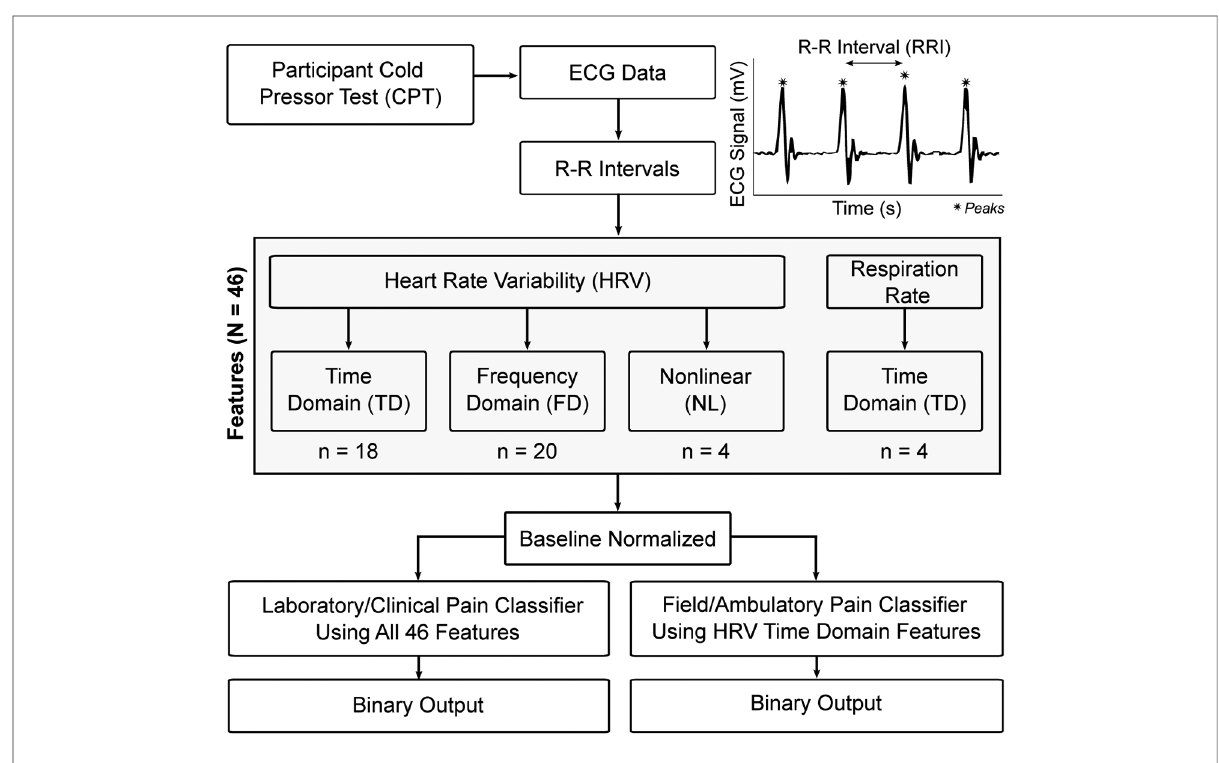
FIGURE 1 Data measurement, featurization, and modeling overview; *peaks of the ECG